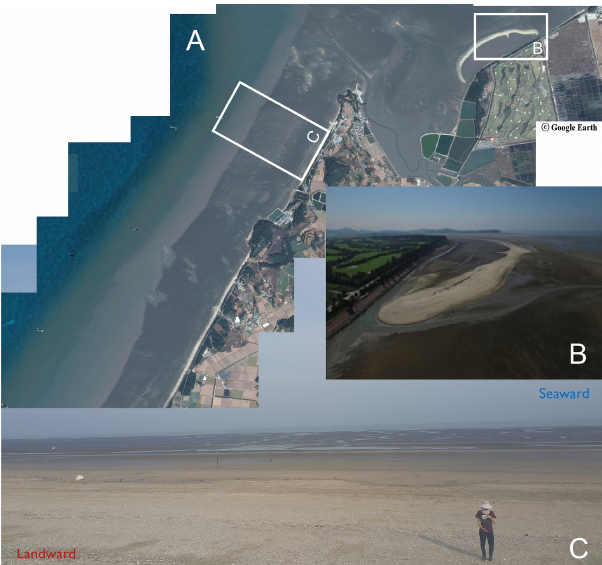
Figure 8. High-tide beaches, multiple swash bars, cheniers, and sandy tidal-flat deposits within the intertidal zone of the open coast along the western Korean coast (modified after Chun et al., 2018). (a) A satellite image with insets of landscape photographs in the Gochang area (from © Google Earth). (b) A chenier on the tidal flat (Chun et al., 2018). (c) A high-tide beach of coarse sand and middle- to low-tide intertidal flats of muddy fine sand. The 2.0–3.0Ø sand predominantly fines seaward. For location, see Fig.